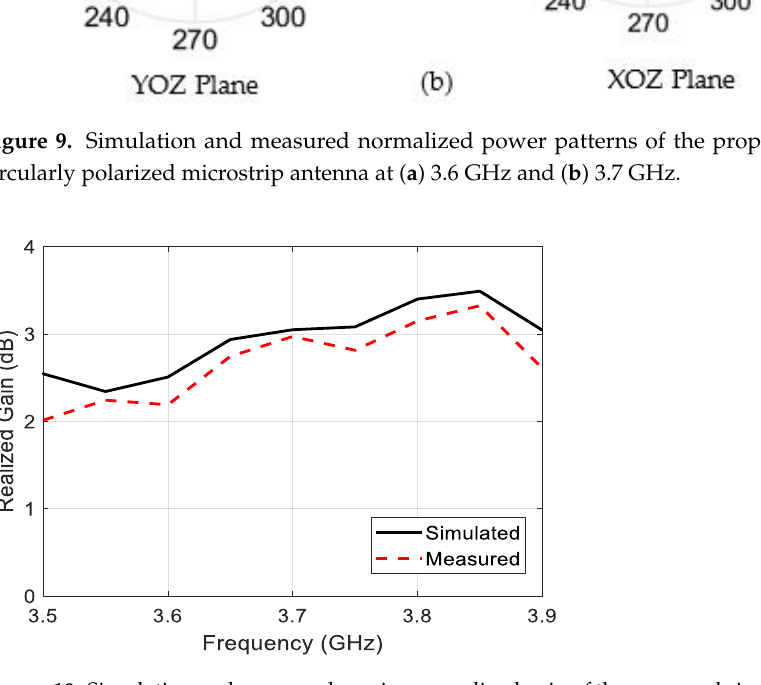
Figure 10. Simulation and measured maximum realized gain of the proposed single-element circularly polarized microstrip antenna.